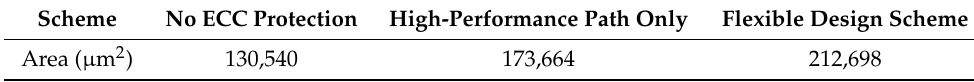
Table 10. Area results for a different design